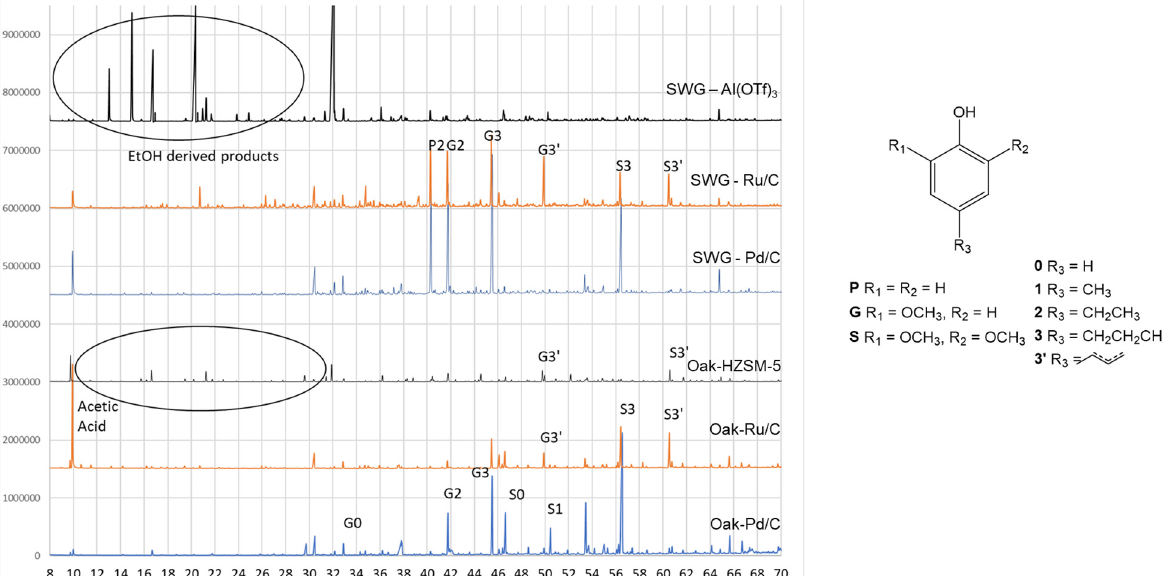
Figure 2. GC/MS chromatograms of phenolic oils produced from lignin-first fractionation and depolymerization in ethanol at 210 ◦ C. Table 2. Mass balance (wt %) of lignin- fi rst fractionation/depolymerization experiments in ethanol at 210 °C.